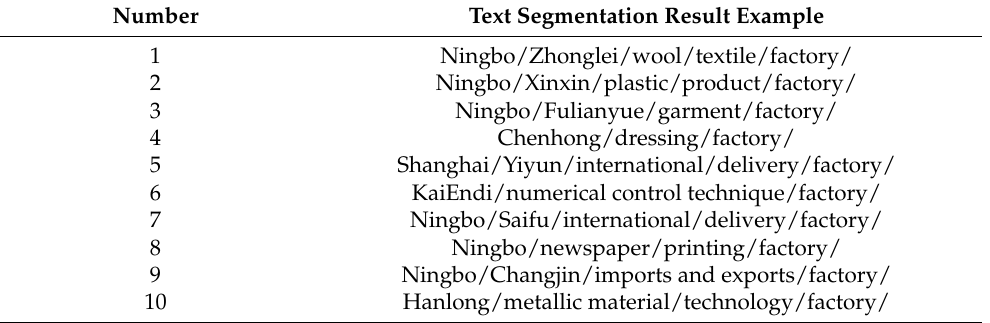
Table 2. Chinese text segmentation result